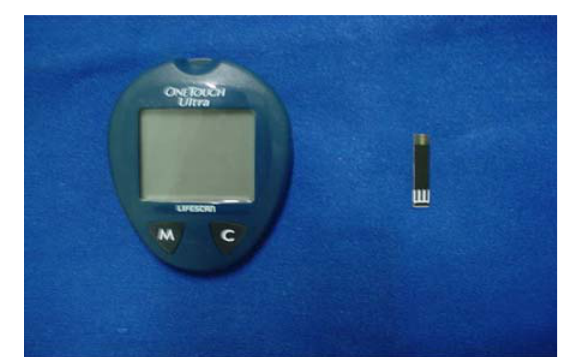
FIGURE 2 - Portable blood glucose test device.